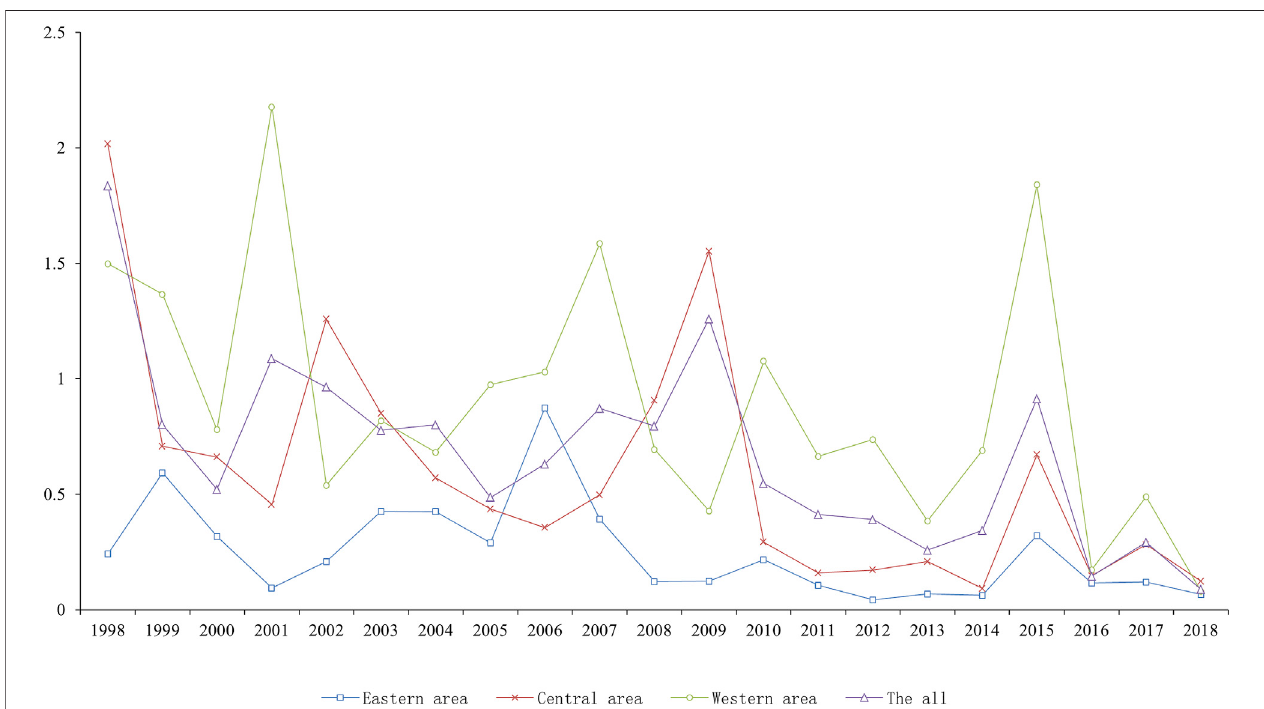
FIGURE 2 | Coef fi cient of variation of carbon emission reduction potential of agricultural green technological progress from 1998 to 2018.